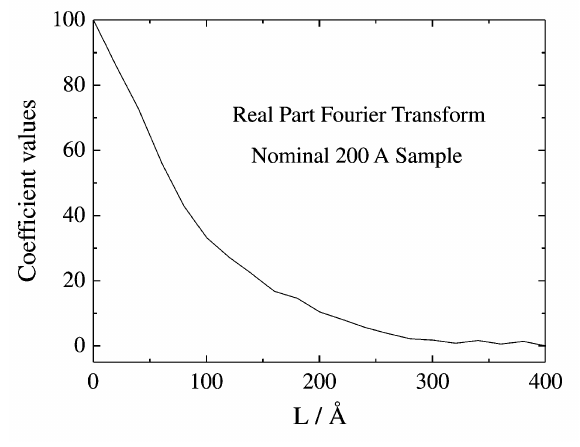
Figure 2. Real part of the Fourier transform for family direction [0 1 0] for sample with nominal 200 Å crystallite size.